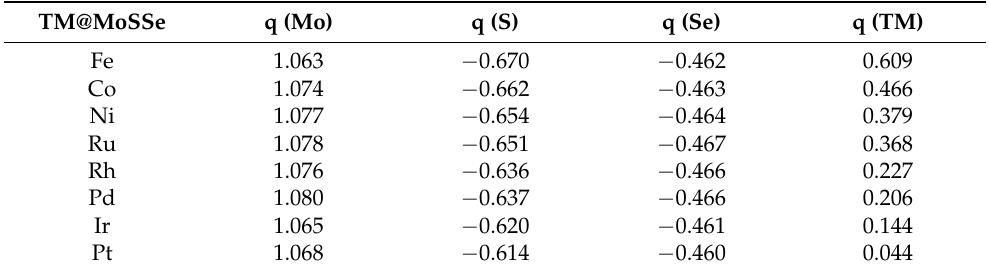
Table 1. Bader charge of TM@MoSSe. The positive values indicate the loss of electrons.